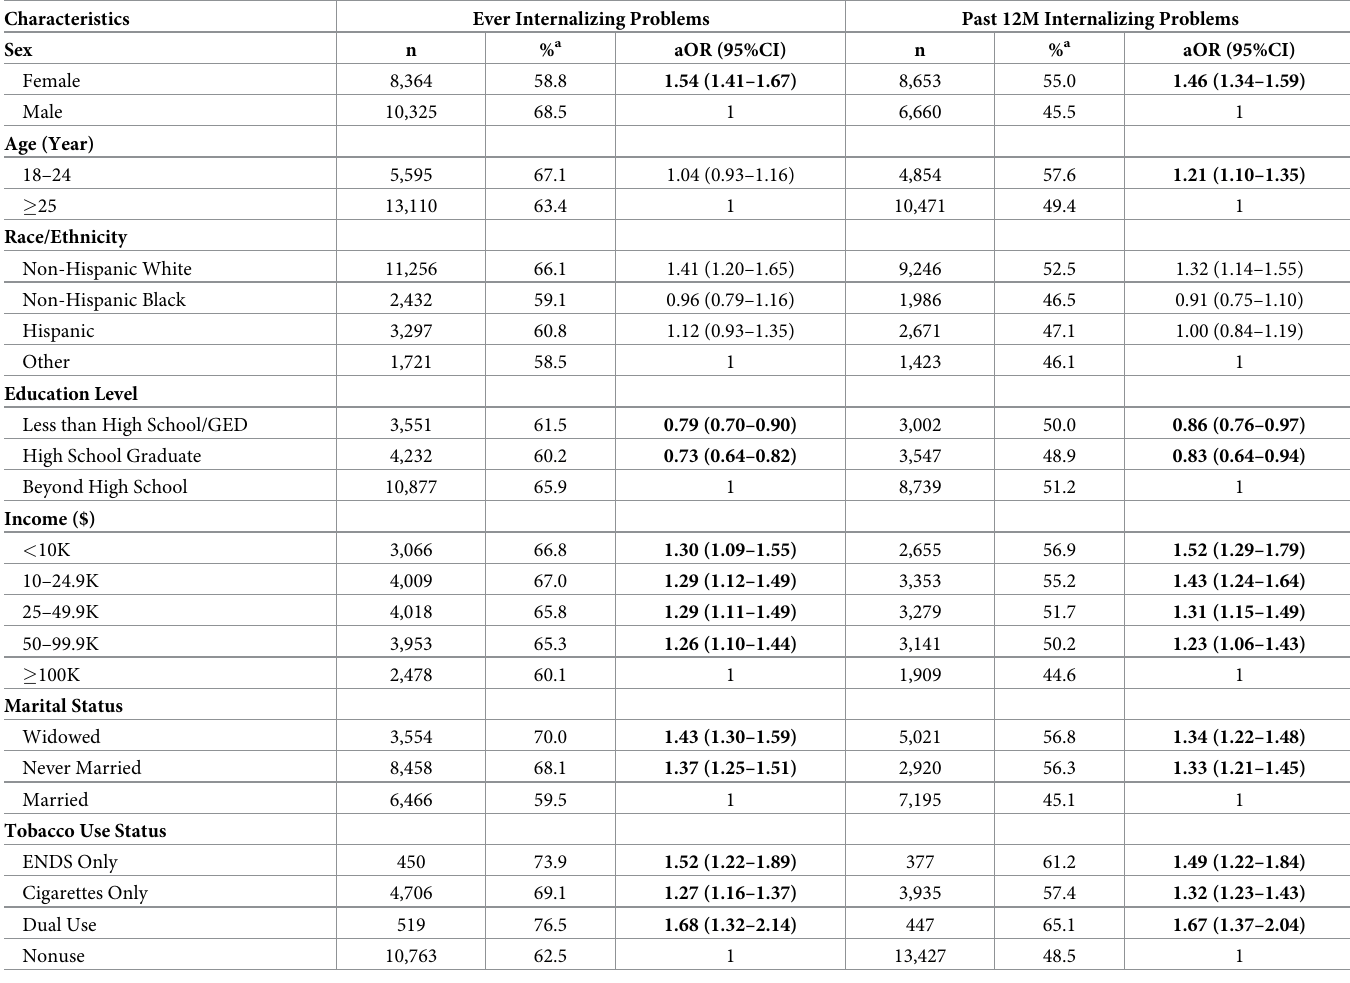
Table 3. Association between ever � and past 12 months �� internalizing problems and sociodemographic